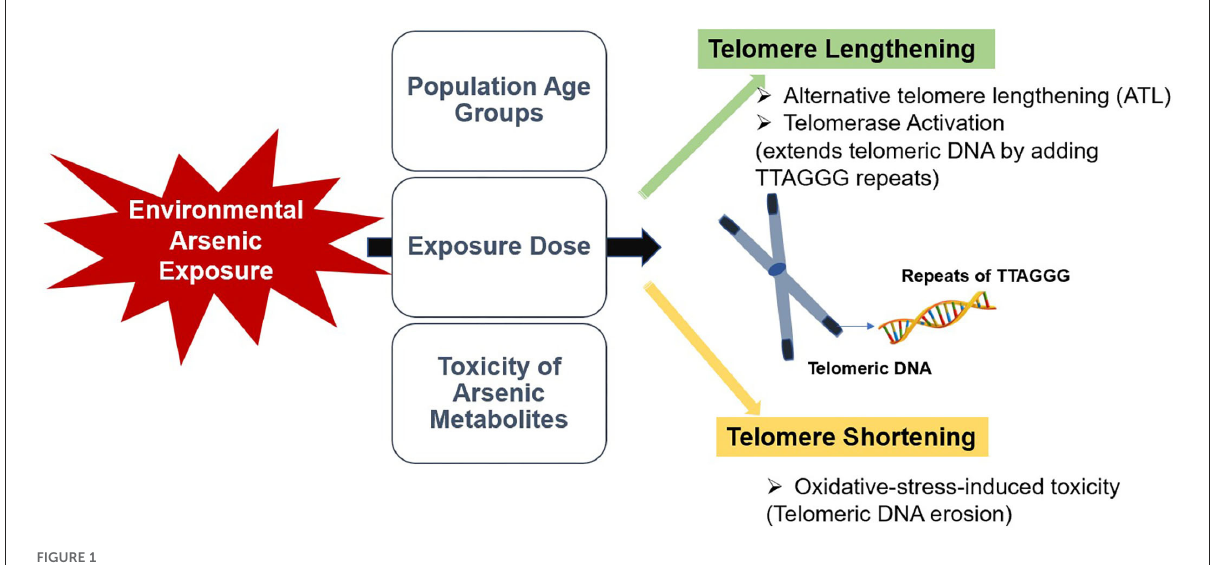
FIGURE1 A summarized illustration of the